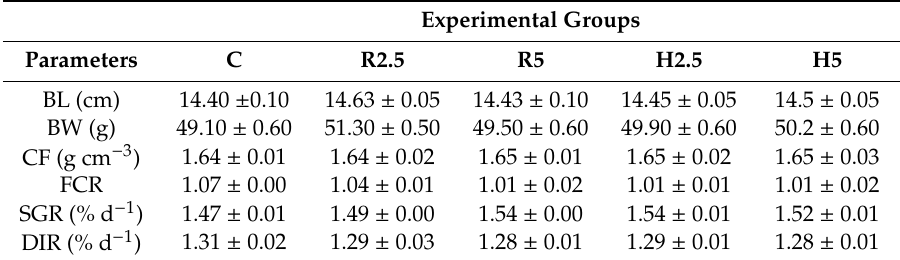
Table 4. Fish body growth parameters at day 90 of the feeding